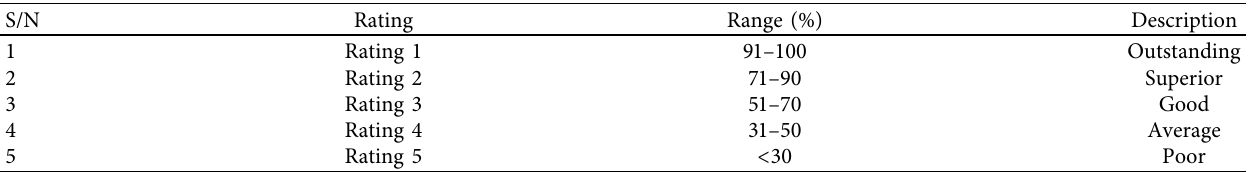
Table 1: Bank performance grading scale.